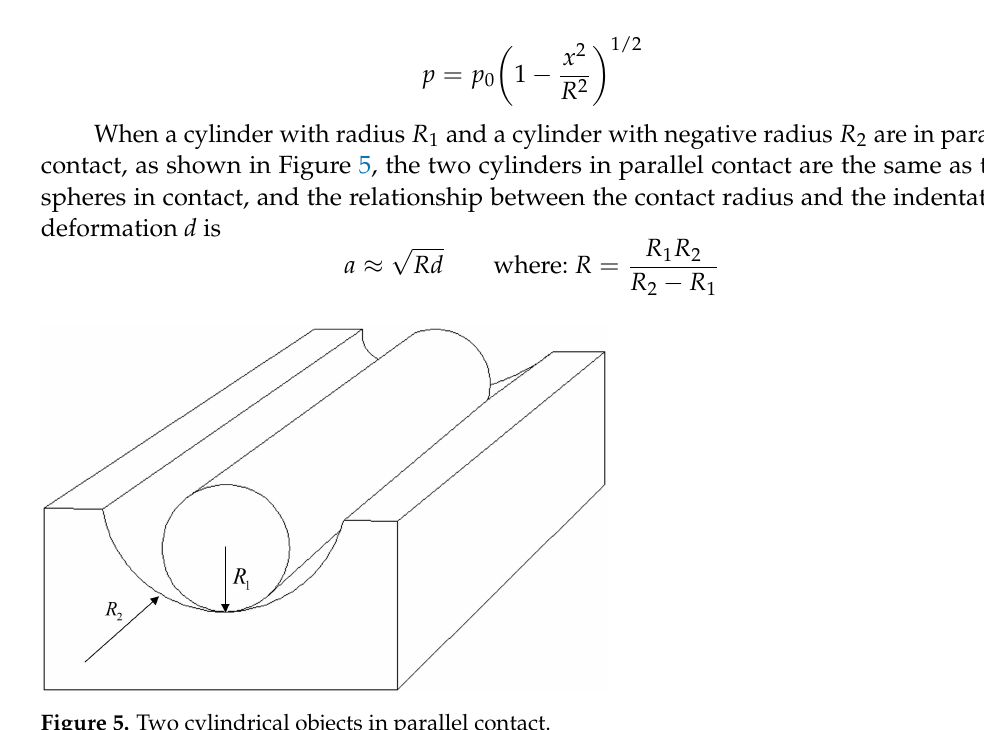
Figure 5. Two cylindrical objects in parallel